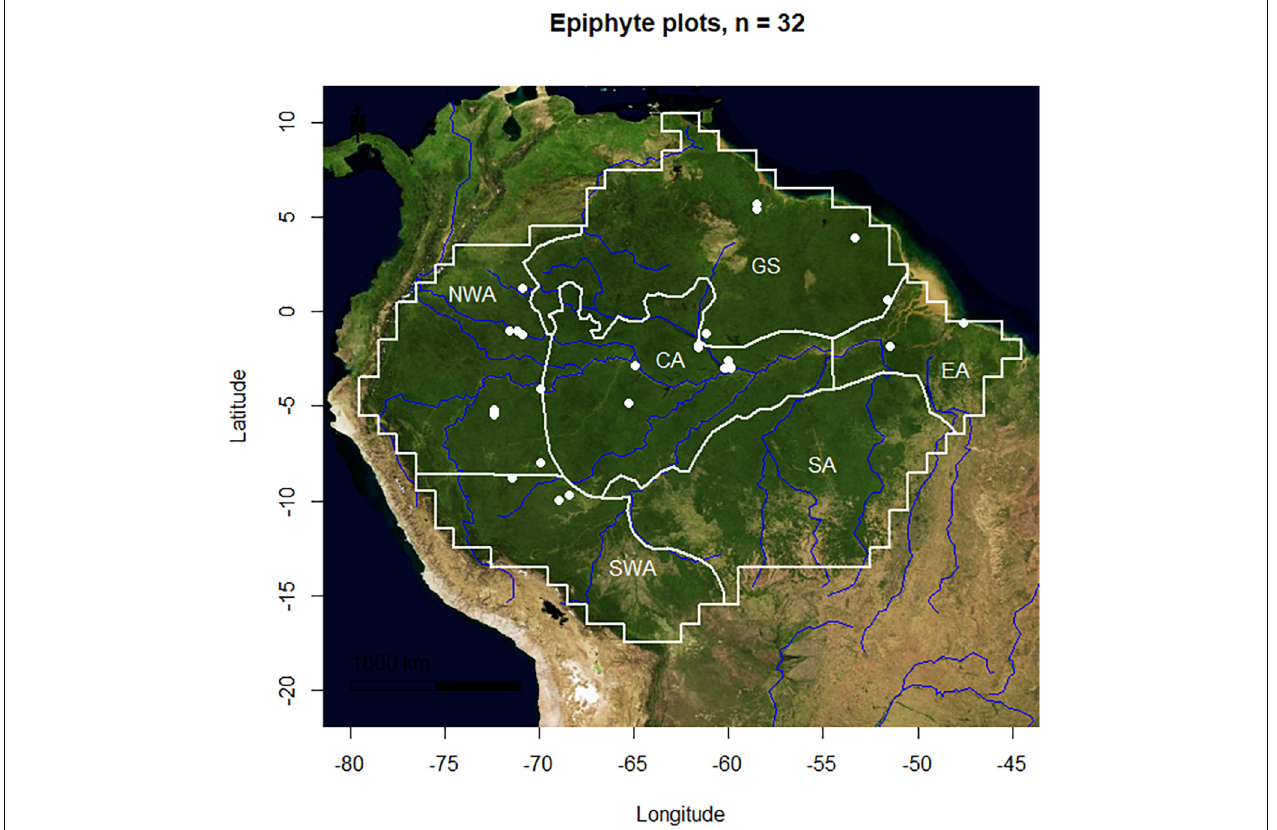
FIGURE 1 | Map showing epiphytes floristic inventories in Amazon biome and its six biogeographic regions. CA, central Amazonia; EA, eastern Amazonia; GS, Guiana Shield; SA, southern Amazonia, NWA, northern part of western Amazonia; SWA, southern part of western